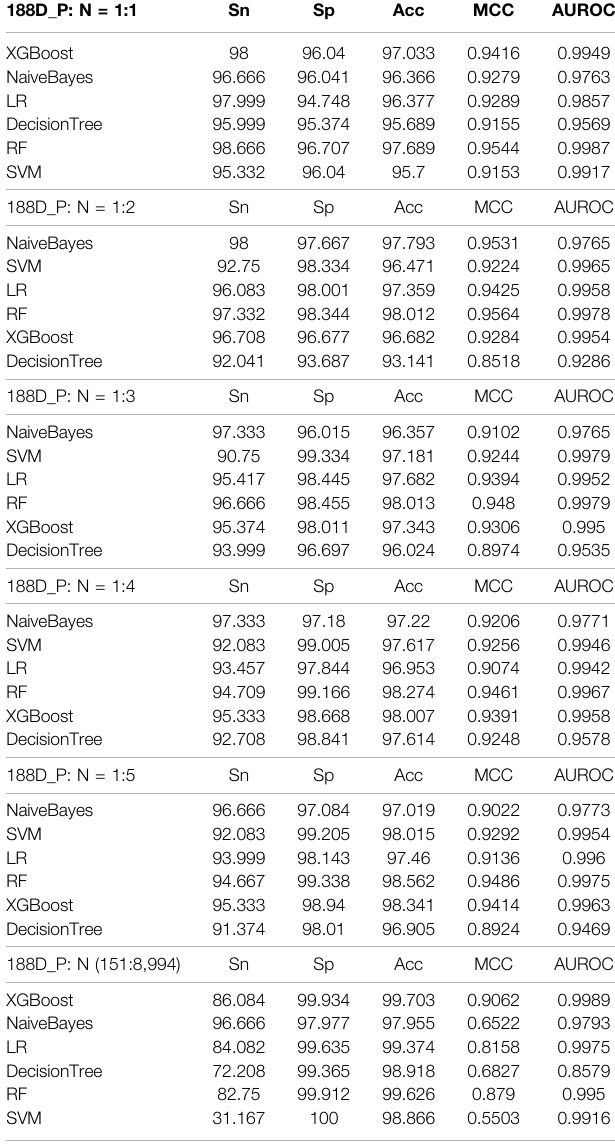
TABLE 1 | Preliminary results of different feature descriptors using different classi fi